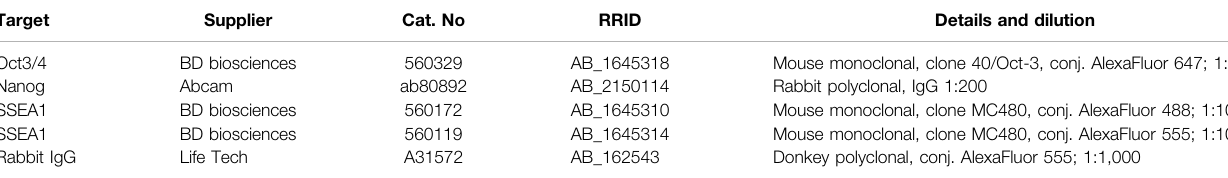
TABLE 1 | Antibodies used in experiments. conj.: conjugated. Target